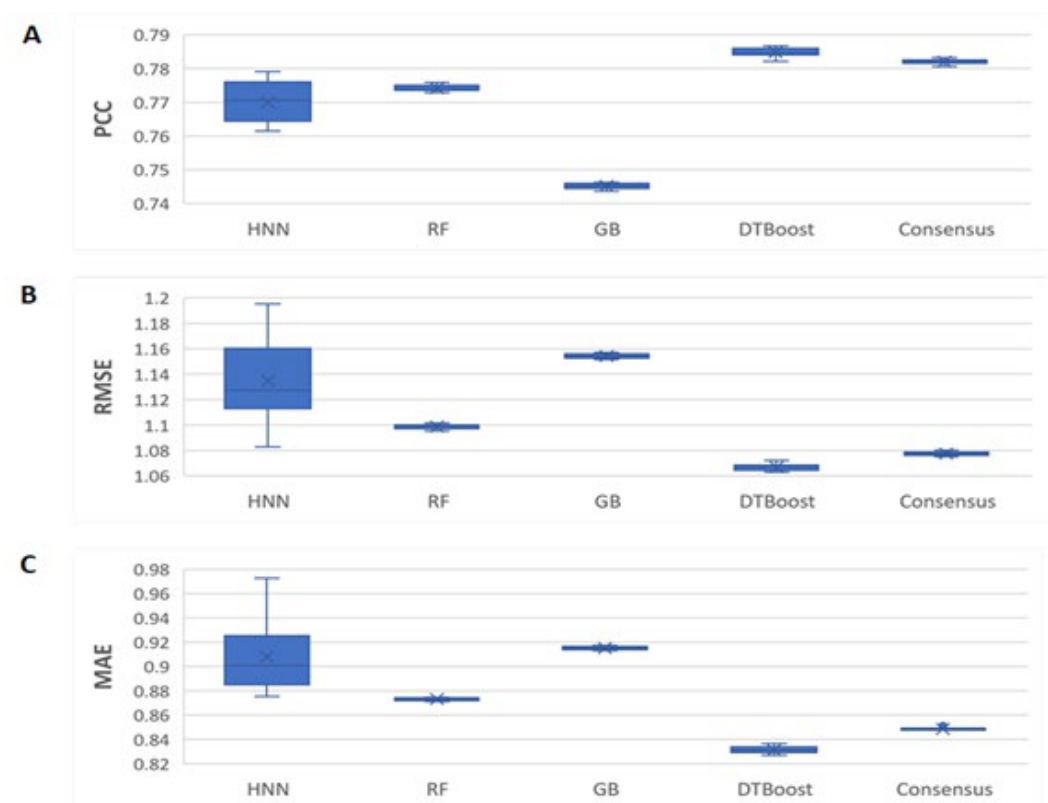
Figure 6. The HNN-denovo performance comparison for the general set combined ligand K d and K i binding data. ( A ) PCC, ( B ) RMSE, and ( C ) MAE of the binding affinity prediction by the HNN-denovo, RF, GB, DT, and consensus